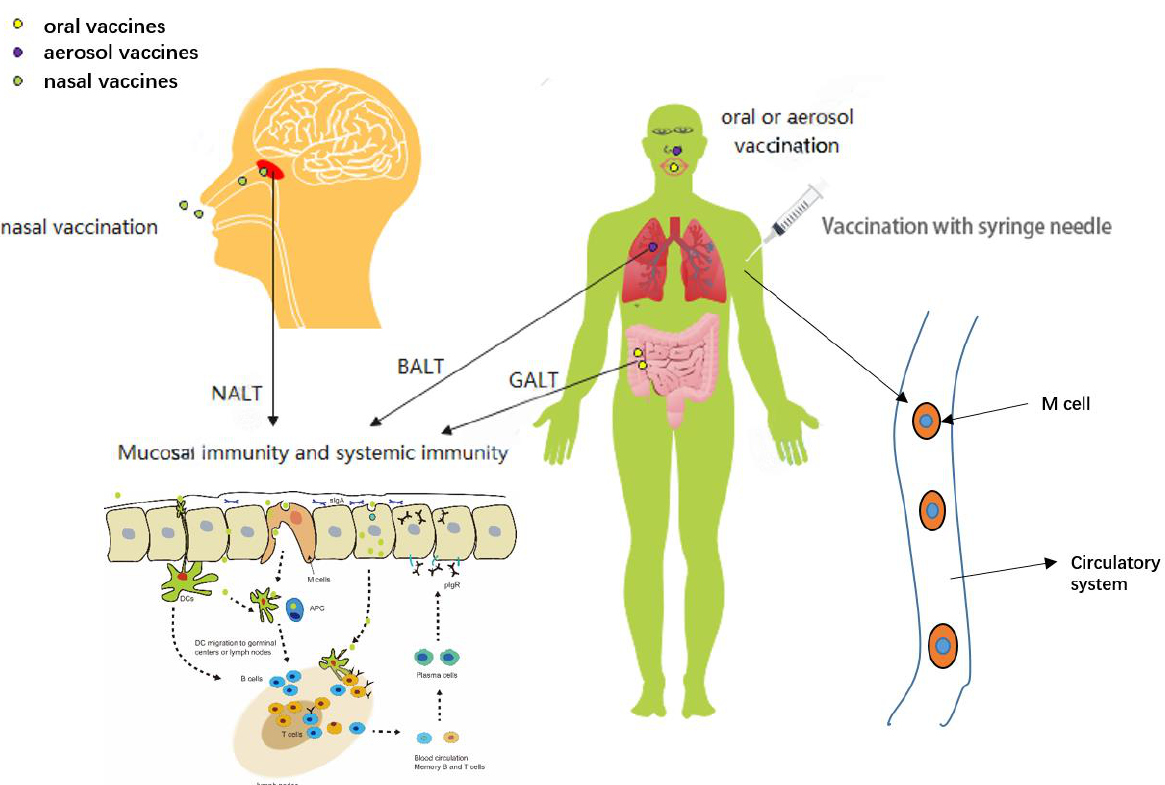
Figure 1. Different routes of vaccination produce different types of immunity at different sites. Oral vaccines along the digestive tract to the GALT, which produce mucosal and systemic immunity. Aerosol vaccines reach BALT by inhalation into the bronchi, which produce mucosal and systemic immunity. Nasal vaccines produce mucosal and systemic immunity at NALT.